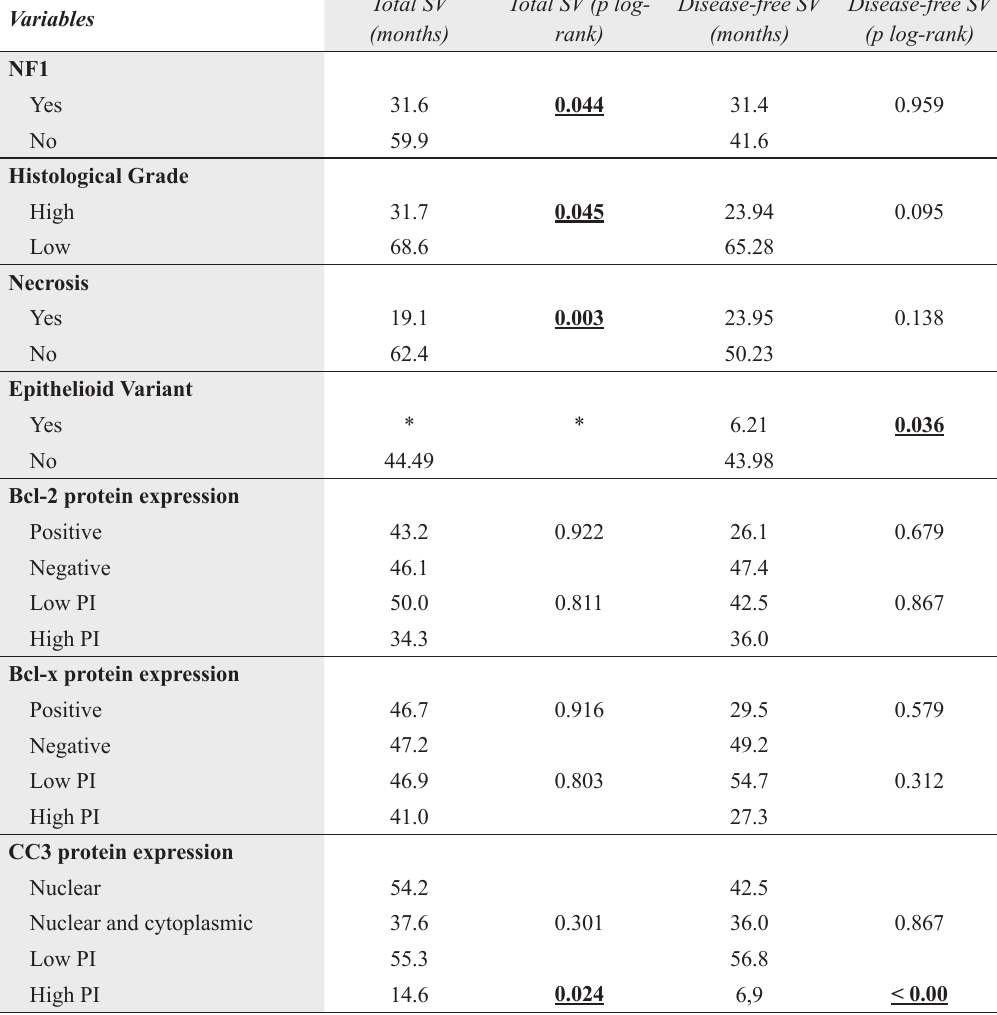
Results of the influence of variables on overall and disease-free survival in patients with malignant peripheral nerve sheath